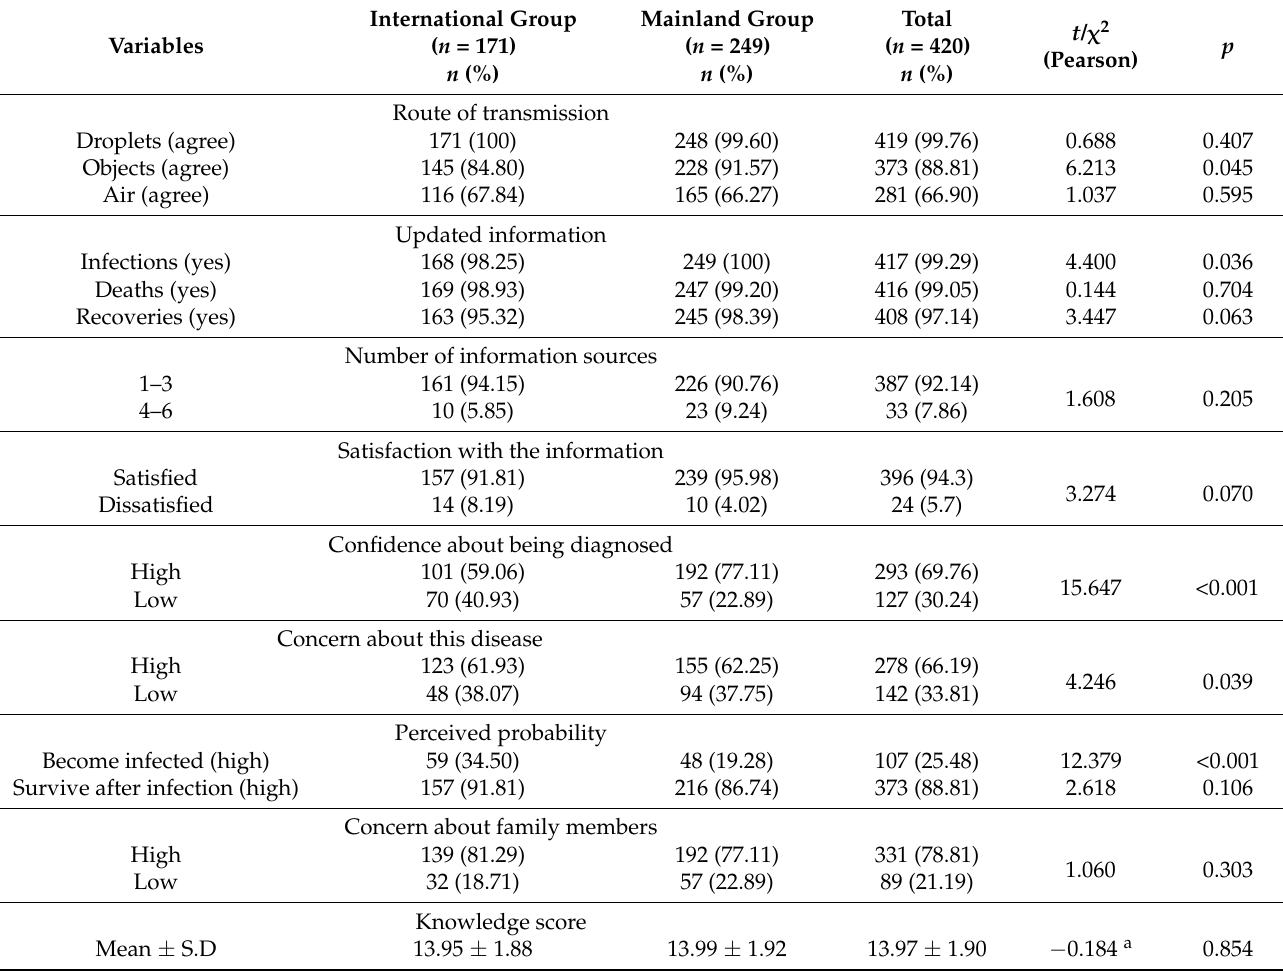
Table 2. Differences in knowledge of